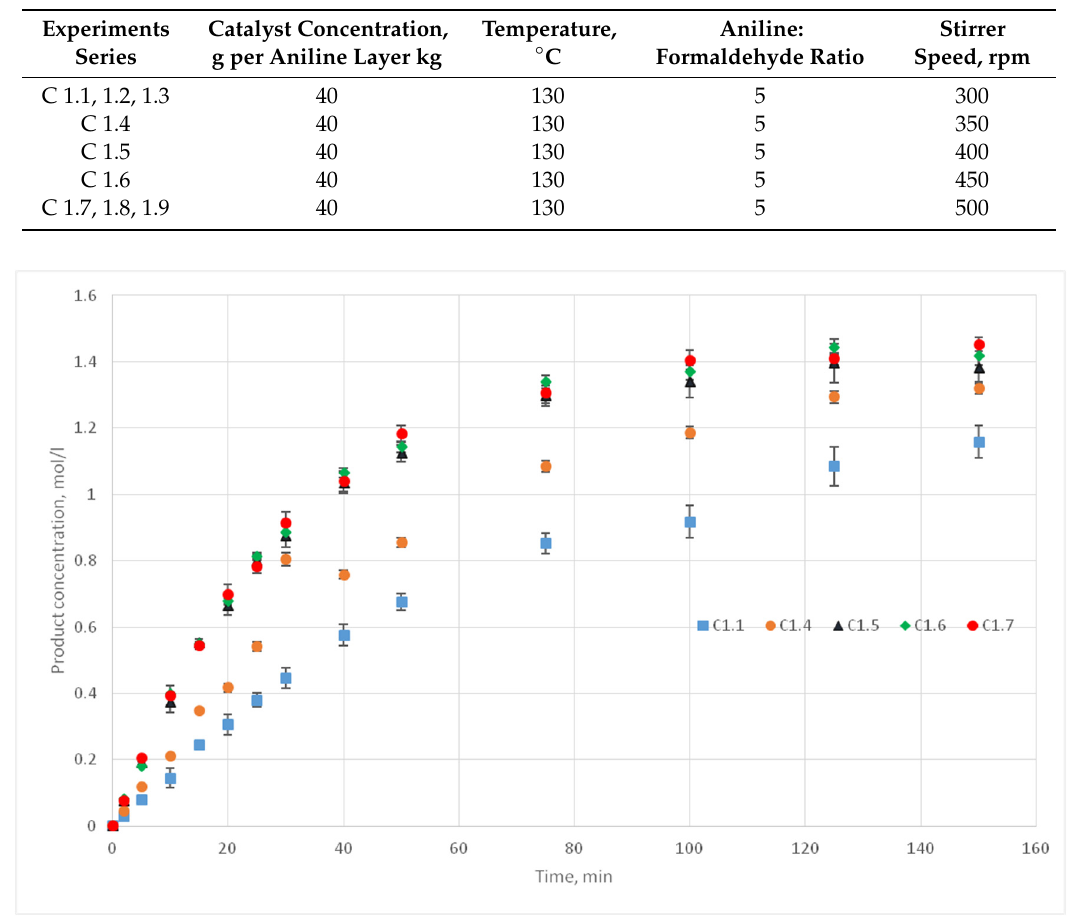
Table 2. C1 Series Experimental Conditions. Table 2. С 1 Series Experimental Conditions.